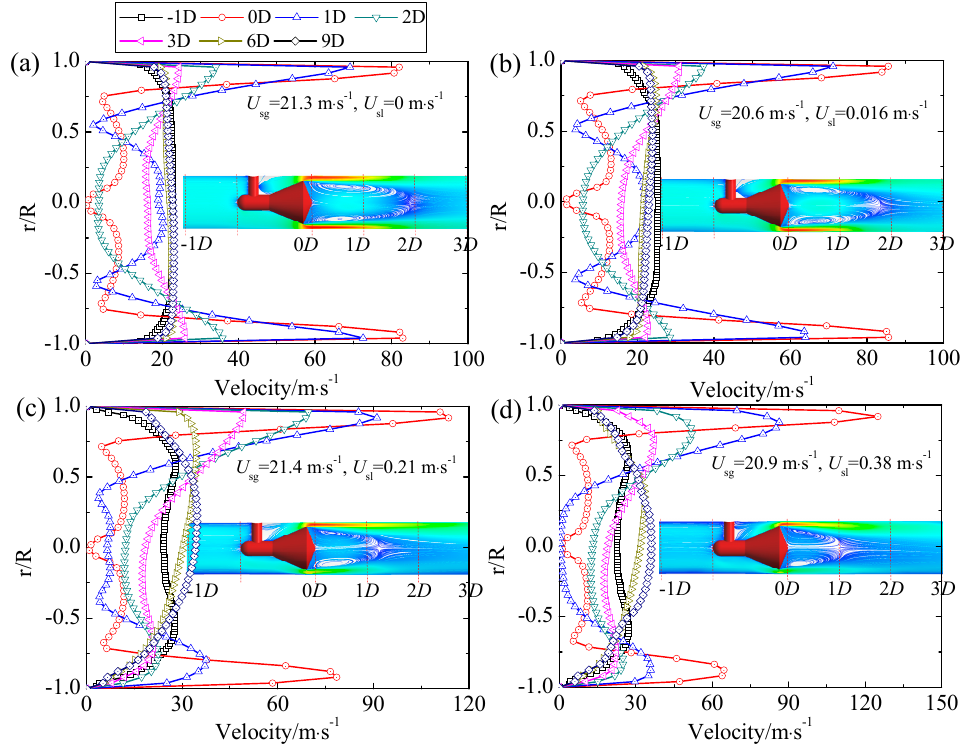
Figure 19. Velocity along Y axis direction under different cross sections. ( a ) U sg = 21.3 m·s − 1 , U sl = 0 m·s − 1 ; ( b ) U sg = 20.6 m·s − 1 , U sl = 0.016 m·s − 1 ; ( c ) U sg = 21.4 m·s − 1 , U sl = 0.21 m·s − 1 ; ( d ) U sg = 20.9 m·s − 1 , U sl = 0.38 m·s − 1 .